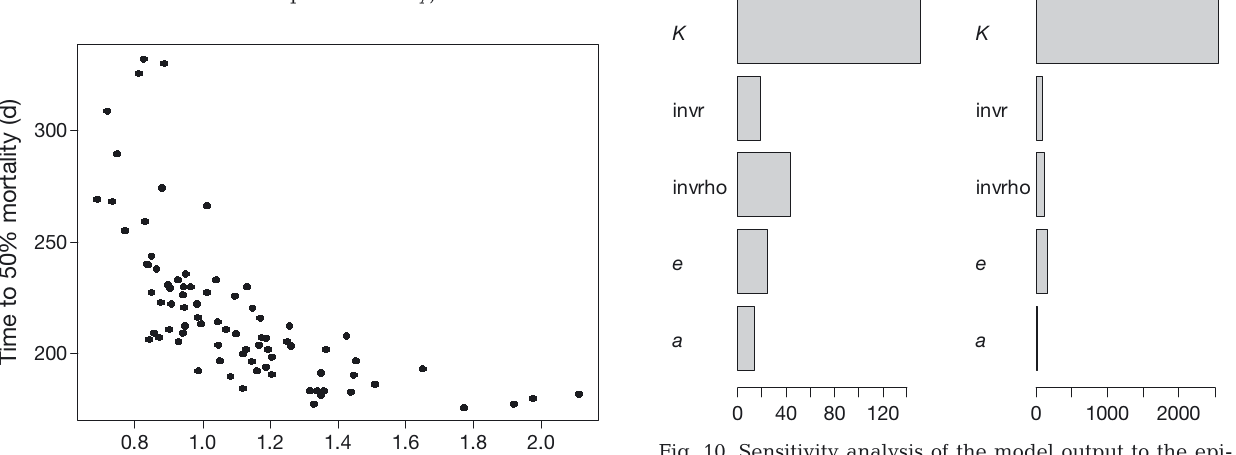
Fig. 8. Comparison between the time to obtain 50% mortal- ity ( T 50 ) for different initial conditions and 2 temperature scenarios: REF and HIGH. Each number represents the T 50 obtained for the 2 scenarios, labelled with the patch number initially infected (1 to 26: eastern part of the bay; 27 to 85: western part of the bay)